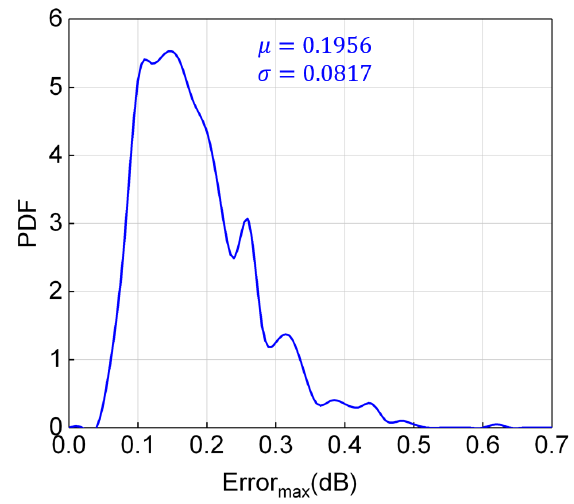
Figure 7. PDF of Error max for arbitrary